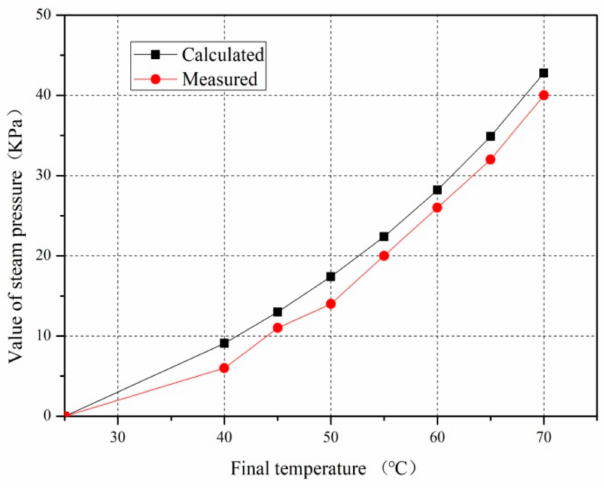
Figure 8. The calculated and tested pressure